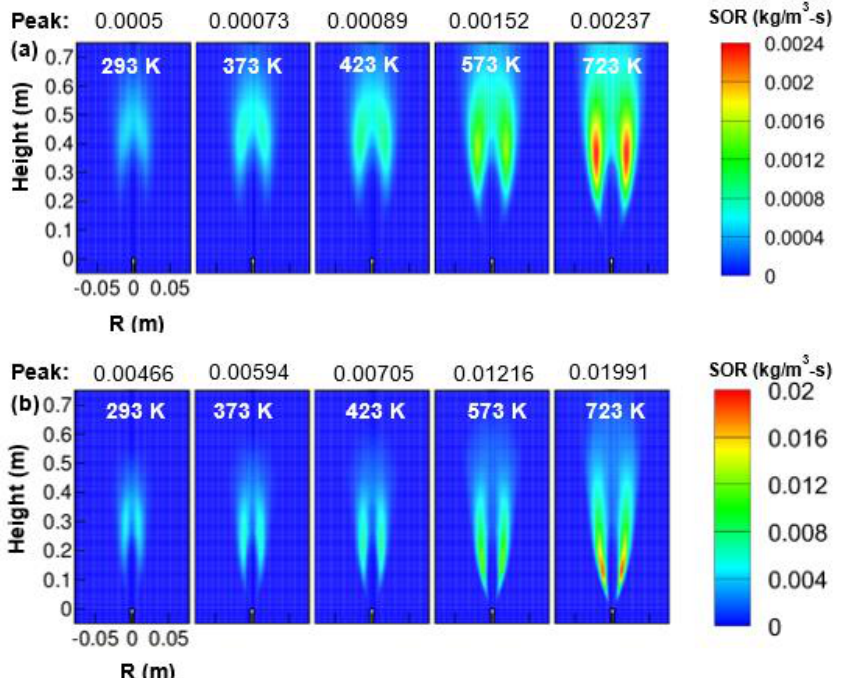
Figure 13. Soot-oxidation-rate (SOR) contour as a function of air temperature; ( a ) 1 atm, and ( b ) 3 atm.